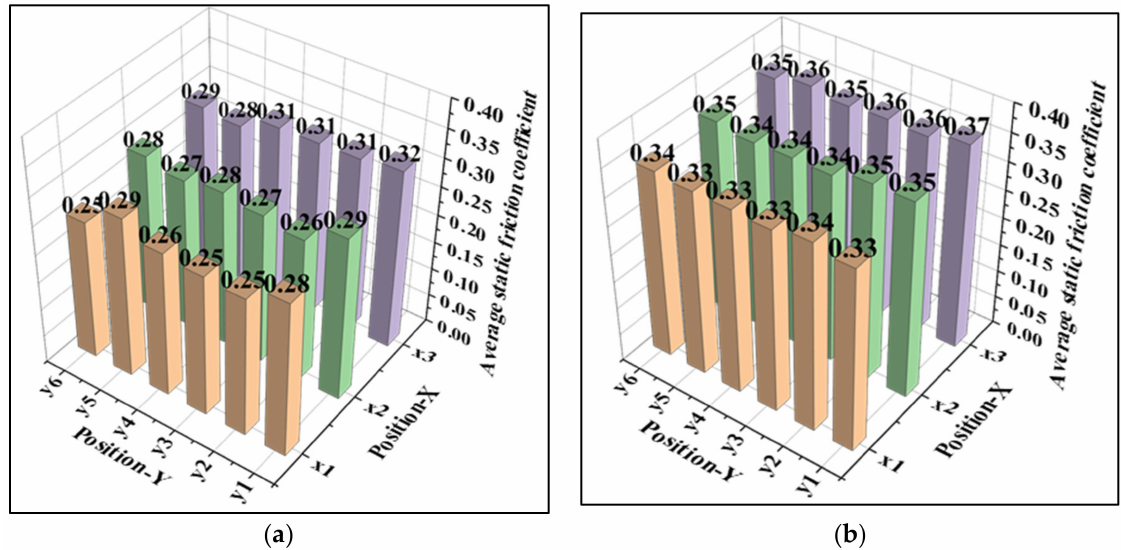
Figure 6. Average static friction coefficients of rice grains and stems averaged over the three measure- ment periods: ( a ) rice grain; ( b ) rice stem.